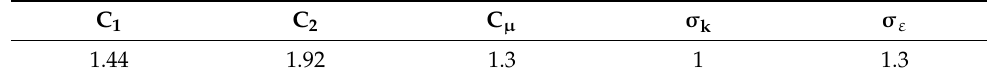
Table 4. Values of the constants of the standard k- ε